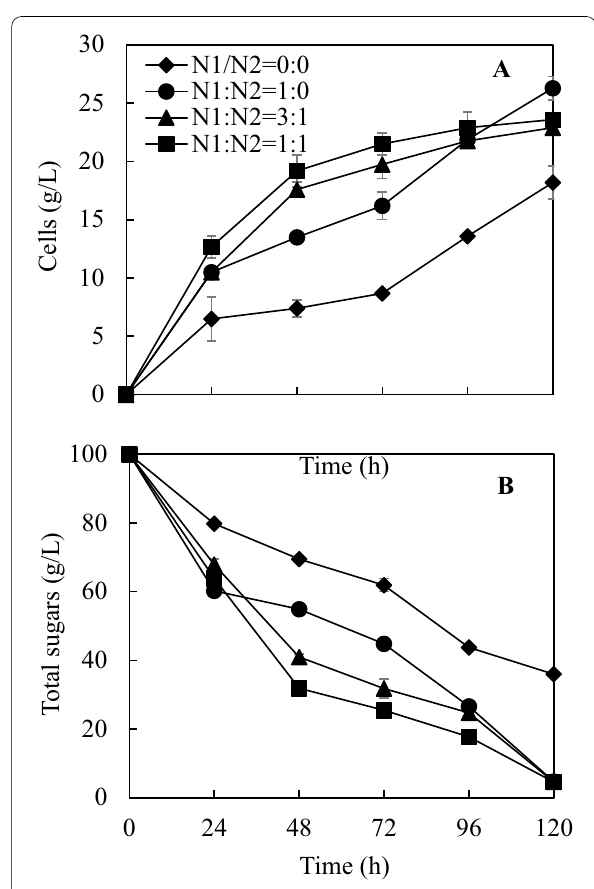
Fig. 1 Effect of nitrogen source ratio on cell growth ( A ) and sugar consumption ( B ) in shake-flask cultivations. N1—NaNO 3 nitrogen, N2—yeast extract nitrogen; total levels of N and P shown in Table